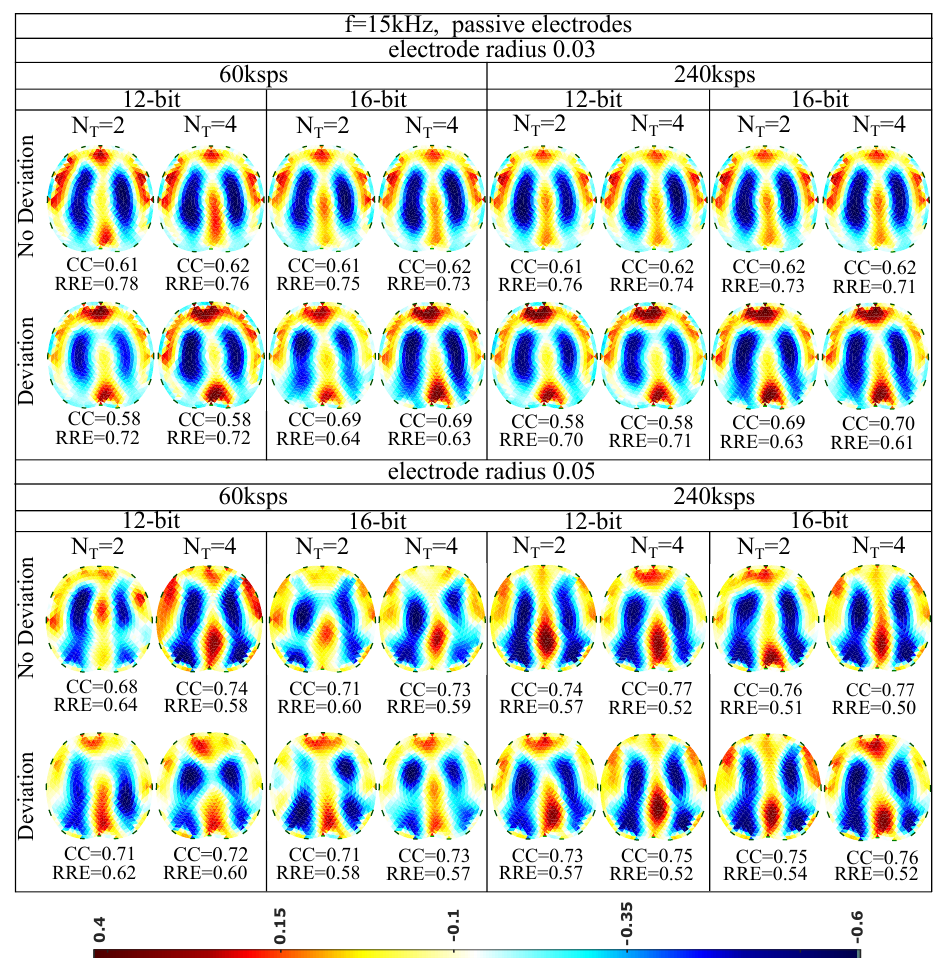
Figure 9. Simulation results for 15 kHz input signal and passive electrode configuration. All further hardware configurations, as well as the corresponding CC s and RRE s, are noted in the